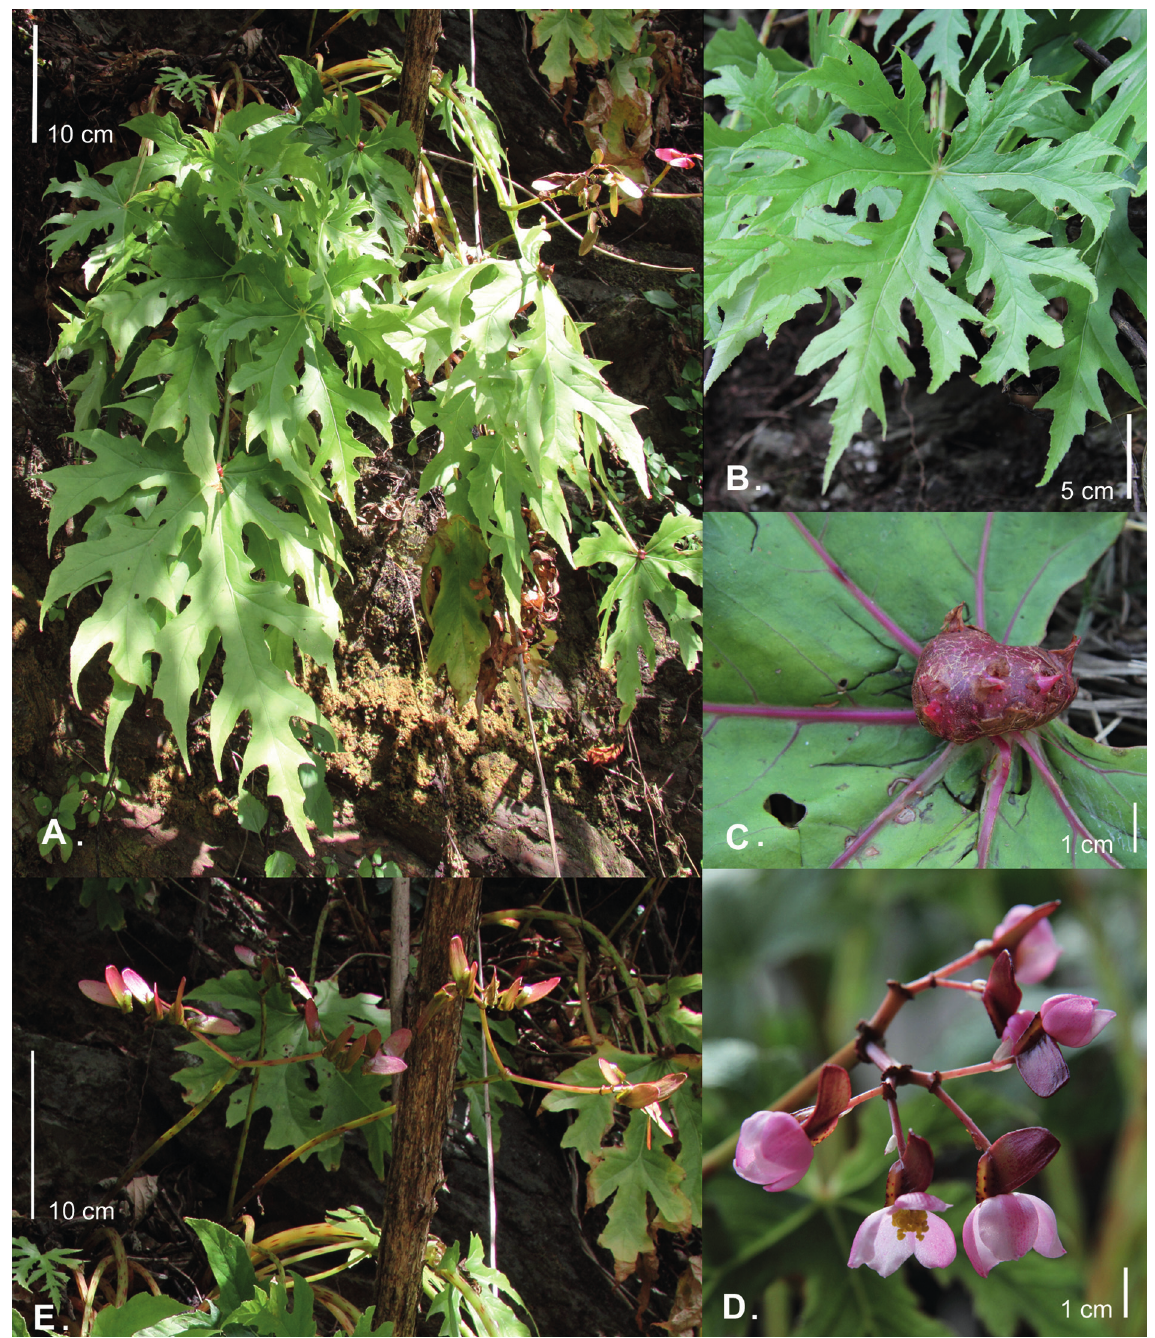
Fig. 34. Begonia koelzii R.Camfield sp. nov. A . Plant habit. B . Leaf. C . Bulbil. D . Young female flowers. E . Fruit. Photographs courtesy of Nick Macer, of a plant in